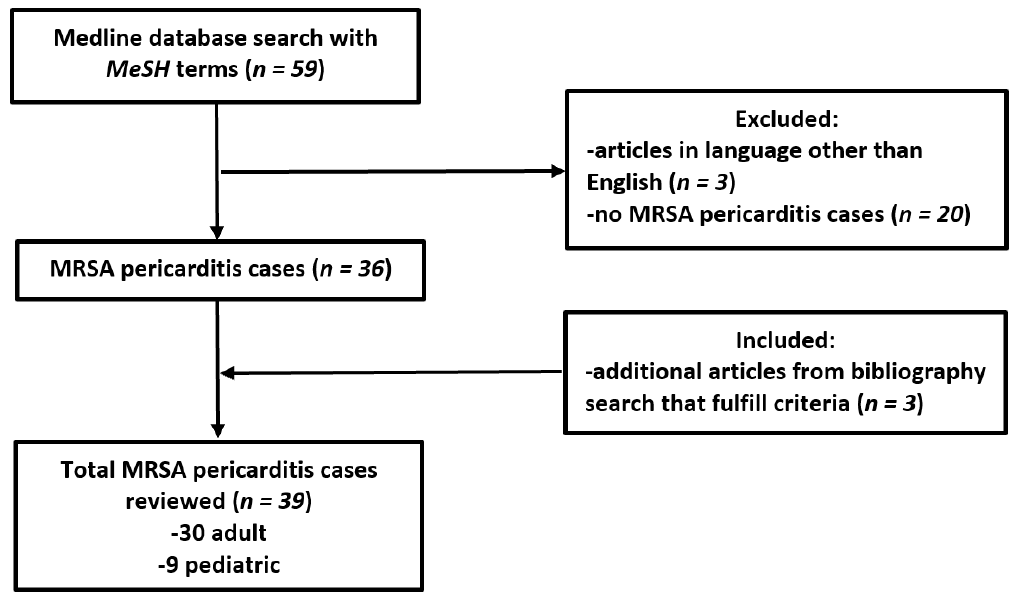
Figure 1. Flow chart of methodology and literature selection according to PRISMA guidelines.